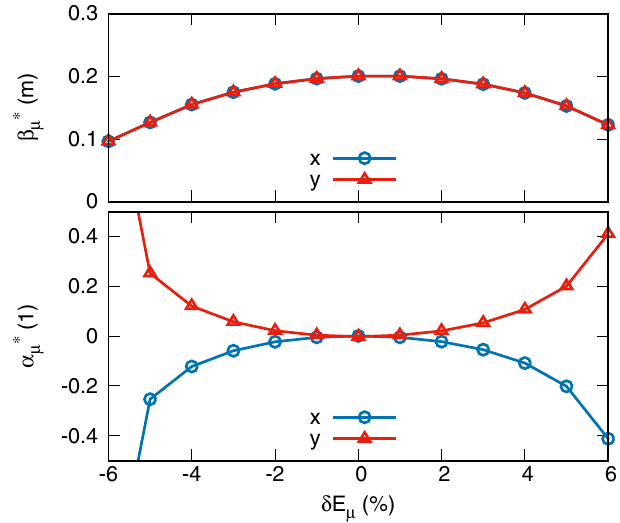
FIG. 4. Twiss parameters β (cid:3) μ and α (cid:3) μ for different energies ranging (cid:2) 6% of the nominal energy.